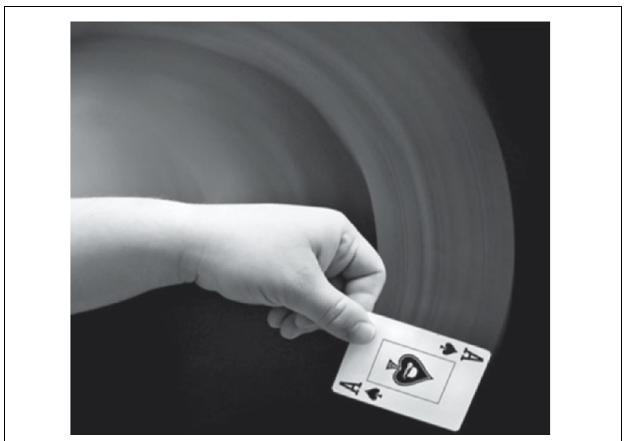
FIGURE 1 | Example of motion streak reported by Apthorp et al. (2013). The blurred line that precedes the object (the playing card) gives an index of motion direction. Photo credit: Tod Klassy.